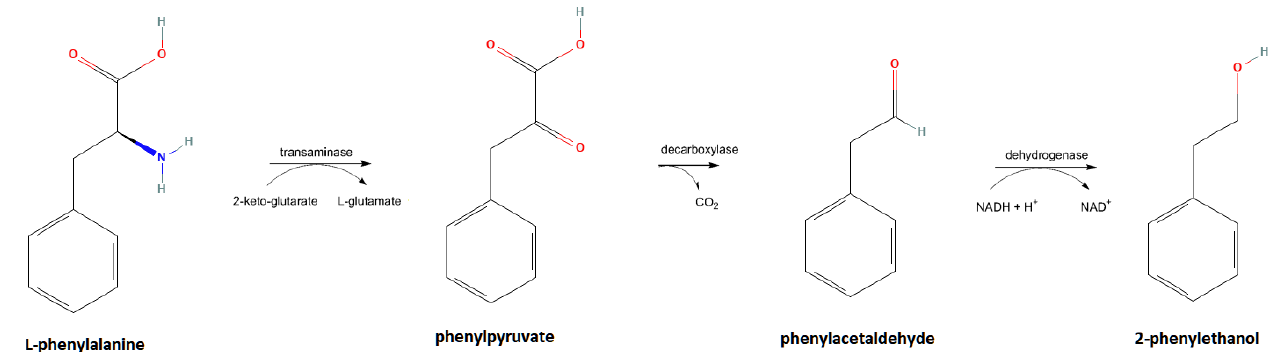
Figure 1. Diagram of the Ehrlich pathway depicting the series of bioconversions in which 2-phenylethanol is produced from L-phenylalanine. Note the structural similarity between L-phenylalanine and 2-phenylethanol. Furthermore, note the various cofactors and byproducts, carbon dioxide (CO 2 ), nicotinamide adenine dinucleotide (NAD + ), reduced nicotinamide adenine dinucleotide (NADH), hydrogen ion (H + ). 2-D structural images from PubChem generated images under allowed usage guidelines [22–26].